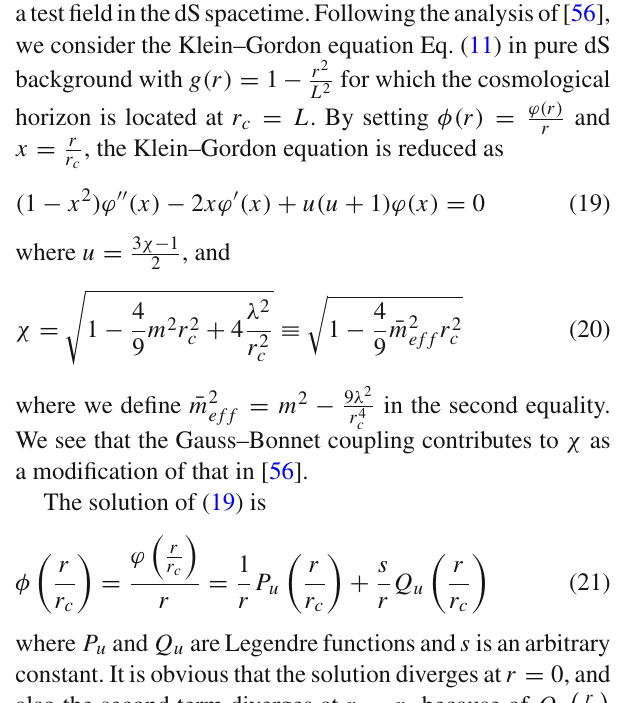
extract two properties from the left panel of Fig. 4.